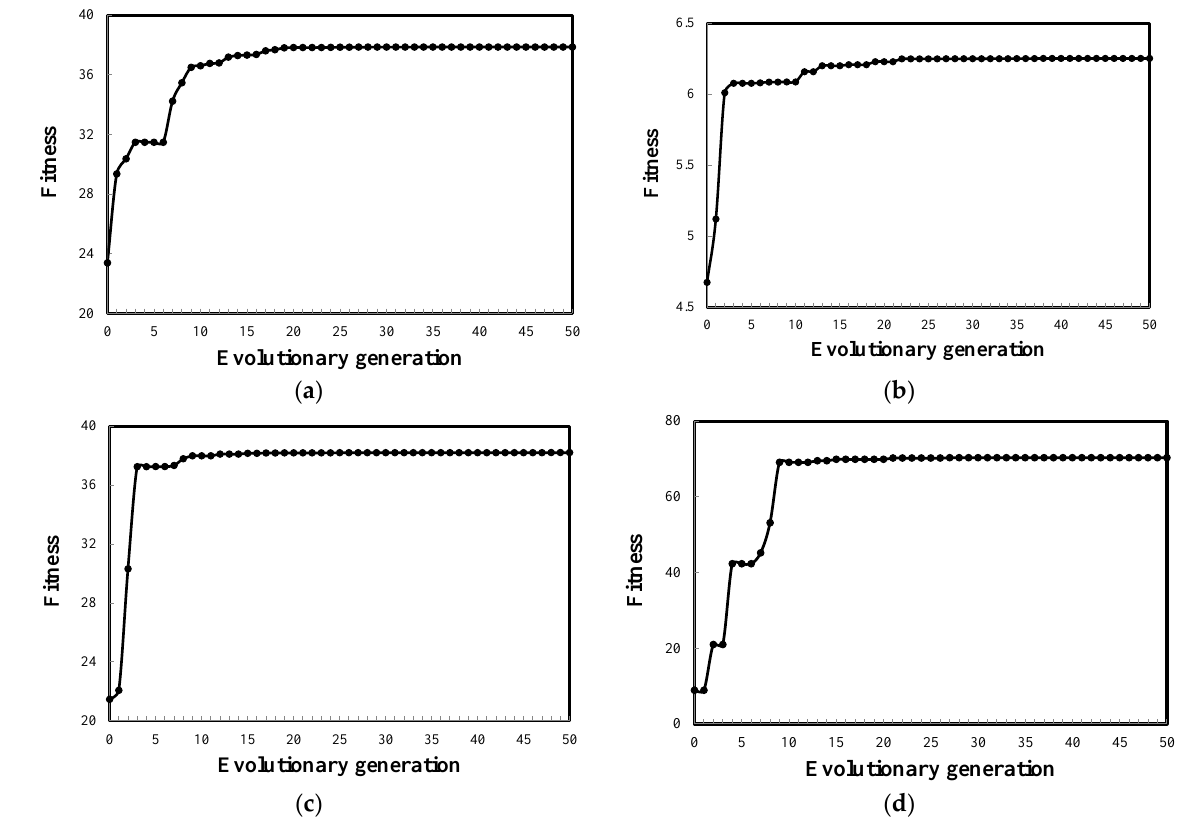
Figure 6. Optimization of the PQE employed in the four control loops of the TC-PQE scheme (Example I): ( a ) top control loop; ( b ) sidestream control loop; ( c ) bottom control loop; ( d ) prefractionator control loop. Table 1. Optimization results of the PQE employed in the four control loops of the TC-PQE Scheme (Examples I and II).